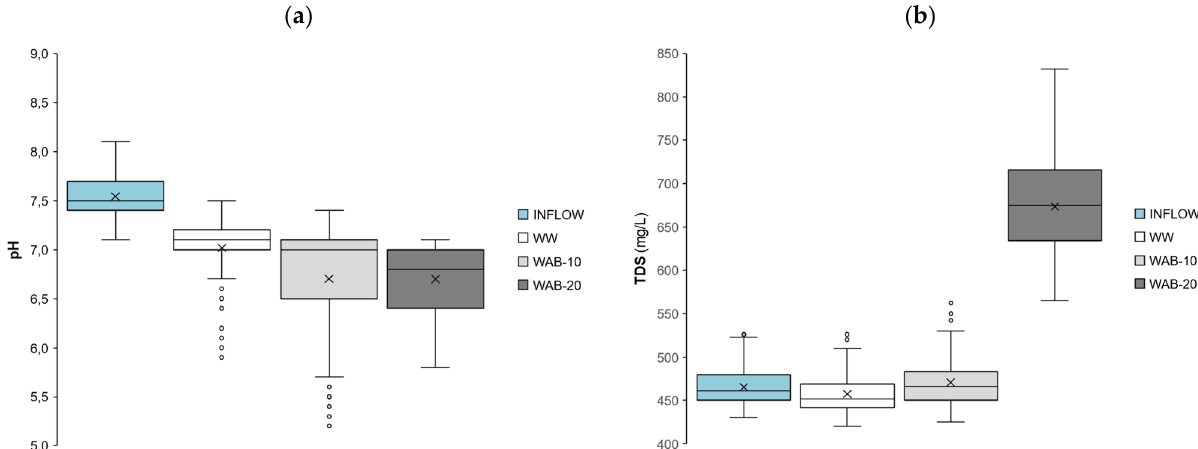
Figure 2. The pH ( a ) and TDS ( b ) in the inflow and outflows of bioreactors WW, WAB-10, and WAB-20. Whiskers represent 1.5 IQRs, boxplots indicate the 25% and 75% quartiles, crosses show the means, dashes in boxes mark the medians, and circles denote values up to 2.2 IQRs.